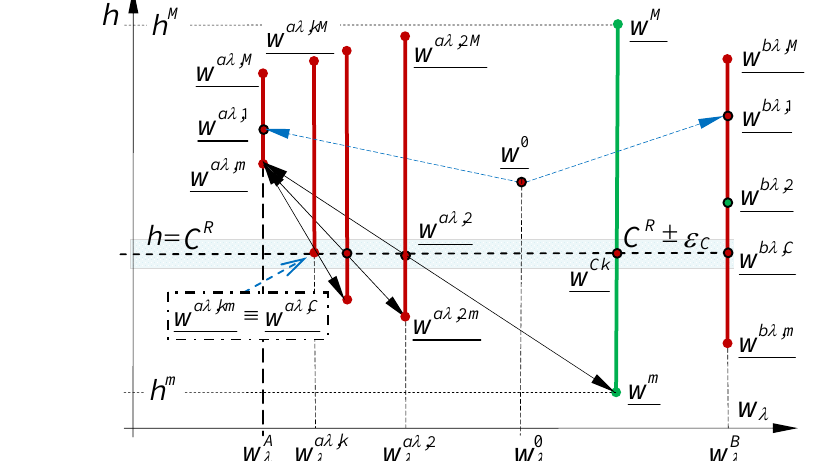
Figure 2 – Overview of the procedure for determining the basic solutions on hyperplanes Рис . 2 – Обзор процедуры определения базовых решений на гиперплоскостях Слика 2 – Приказ поступка одређивања основних решења на хиперравнима Practically, in all rows of the matrix G 0 except in the  row, }{\Jj;Jj; g   10 0 )j,j(